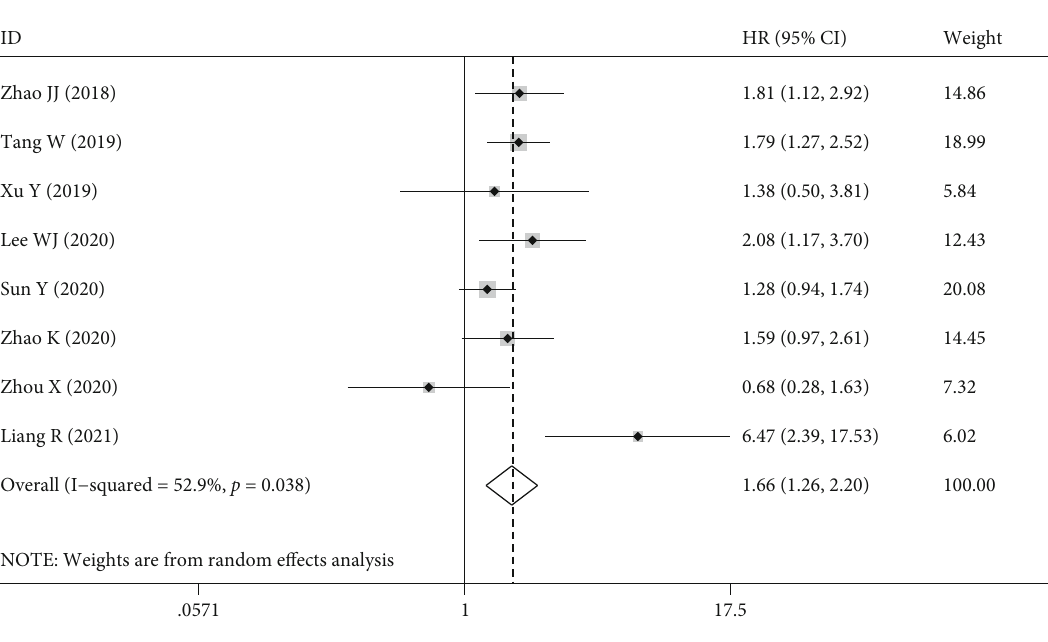
Figure 2: Forest plot for